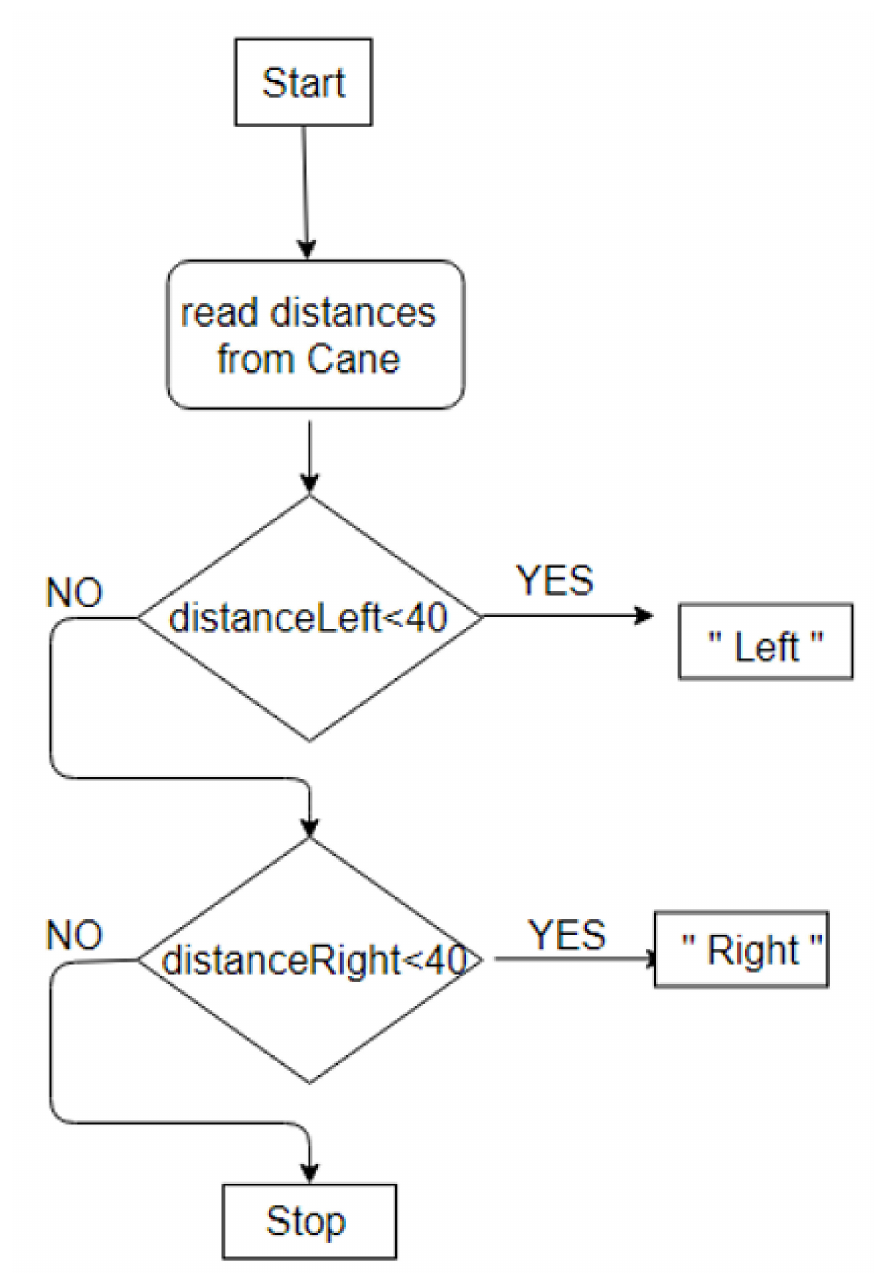
Figure 8. Diagram to detect